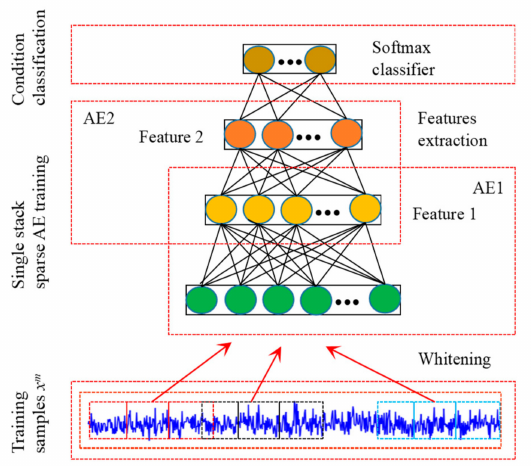
Figure 3. Illustration of the SAE training